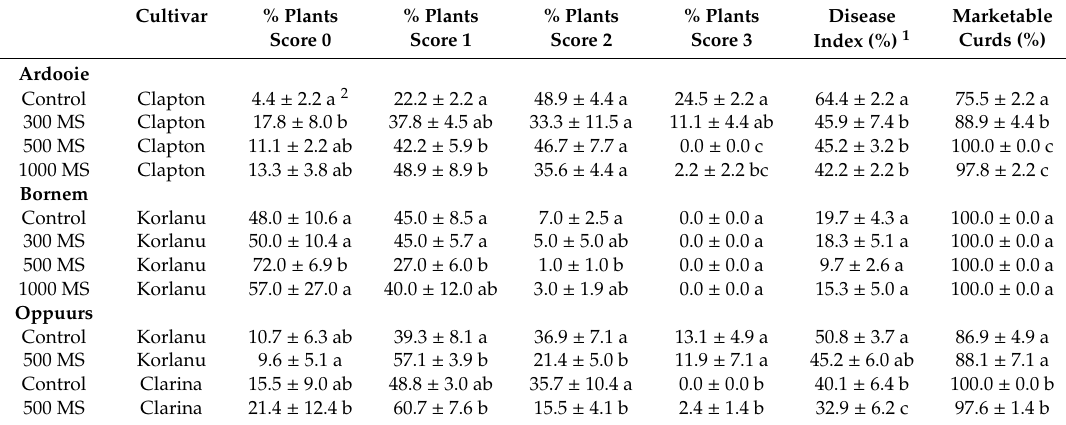
Table 1. Biocontrol of Verticillium wilt of cauliflower by V. isaacii Vt305 in field conditions at three locations (Ardooie and Bornem in 2014 and Oppuurs in 2015). Cauliflower seeds (cv Clapton,